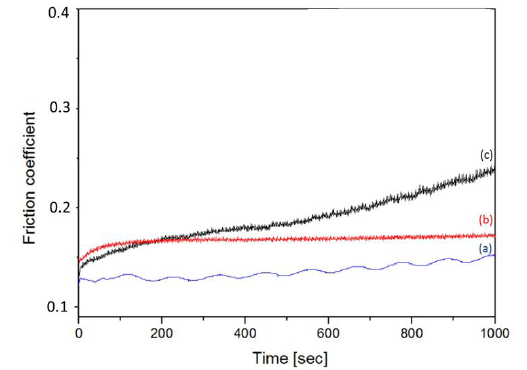
Figure 3. Evolution of friction coefficient versus time equimolar TiNbZr alloys with different weight ratios of NH